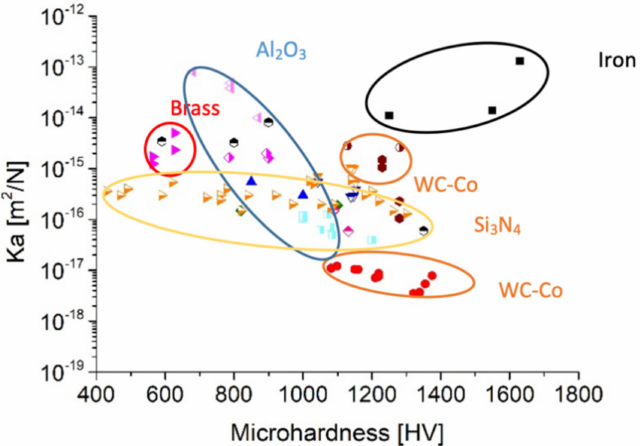
Figure 1. Specific wear coe ffi cients taken from the literature with the indication of the counterfaces used during the tribological